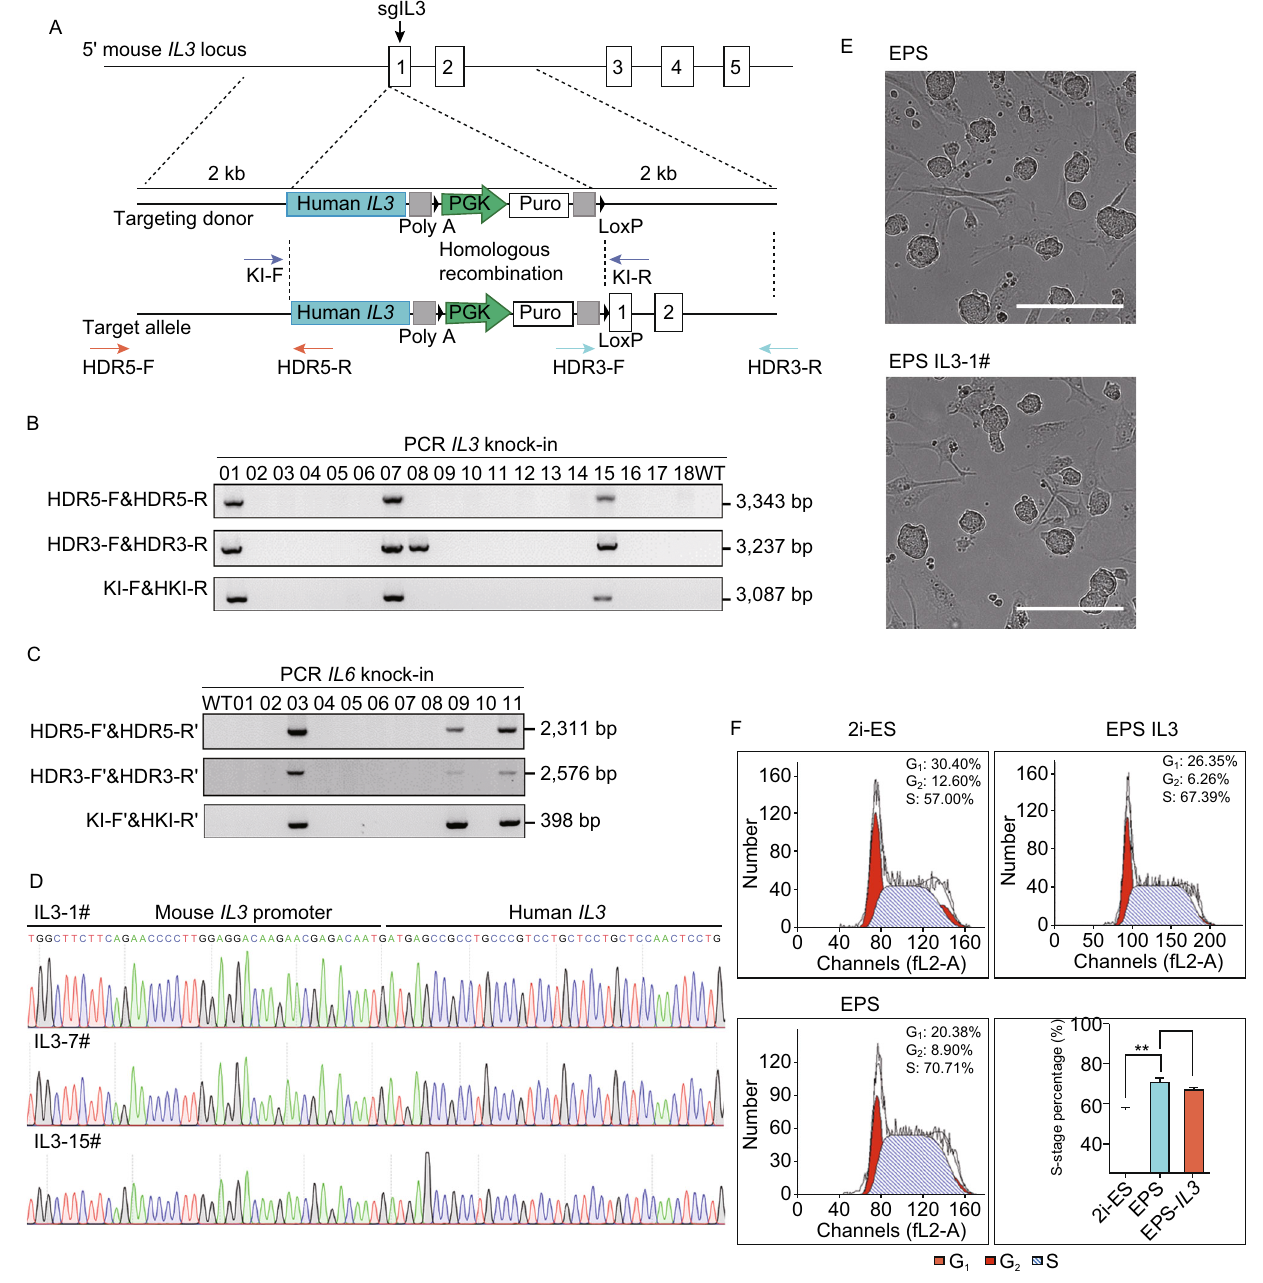
Figure 3. Generation of human IL3 or IL6 gene knock-in EPS cells. (A) Diagrams of generating the human IL3 gene knock-in EPS cells. Primers for knock-in detection were indicated as pairs of arrows. (B and C) Representative images showing identi fi cation of successful knock-in of human IL3 (B) or IL6 (C) genes into its corresponding locus in mouse EPS cells. EPS cells without gene targeting were used as the wild-type control. WT, wild type. (D) Sequencing results of the promoter sites at the mouse Il3 locus showing the correct insertion of the human IL3 gene. (E) Representative images showing the morphology of EPS and EPS- IL3 clones. Scale bars, 50 μ m. (F) Representative FACS analysis of the cell cycle of 2i-ES cells, EPS cells and EPS- IL3 cells. The percentages of cells at G 1 , S and G 2 are shown on the right side of each chart. Bar chart shows the S-stage percentage of each cell type. Error bars indicate SEM ( n = 3). Signi fi cant differences between values of 2i-ES cells and EPS cells were found by t -test (** P <